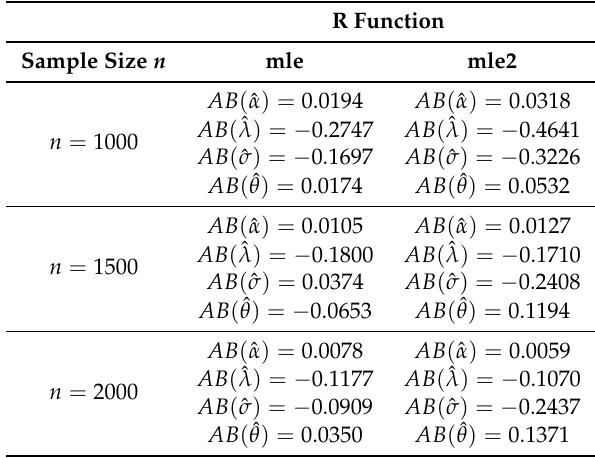
Table 2. Average bias (AB) for the composite Weibull–Pareto (CWL) distribution model involving 1000 simulations of samples of size n for the mle (second column) and mle2 (third column) functions.